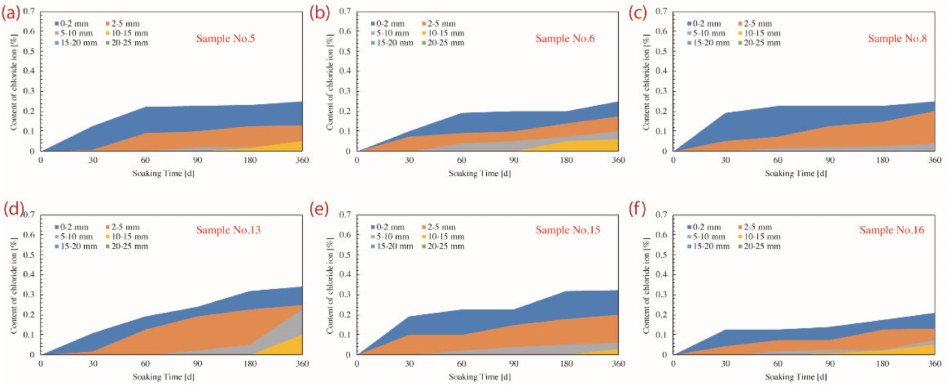
Figure 12. Depth of chloride ion penetration and the content of chloride ion of concrete samples corroded for various days under the long-term soaking environment. ( a ) Sample No.5; ( b ) Sample No.6; ( c ) Sample No.8; ( d ) Sample No.13; ( e ) Sample No.15; ( f ) Sample